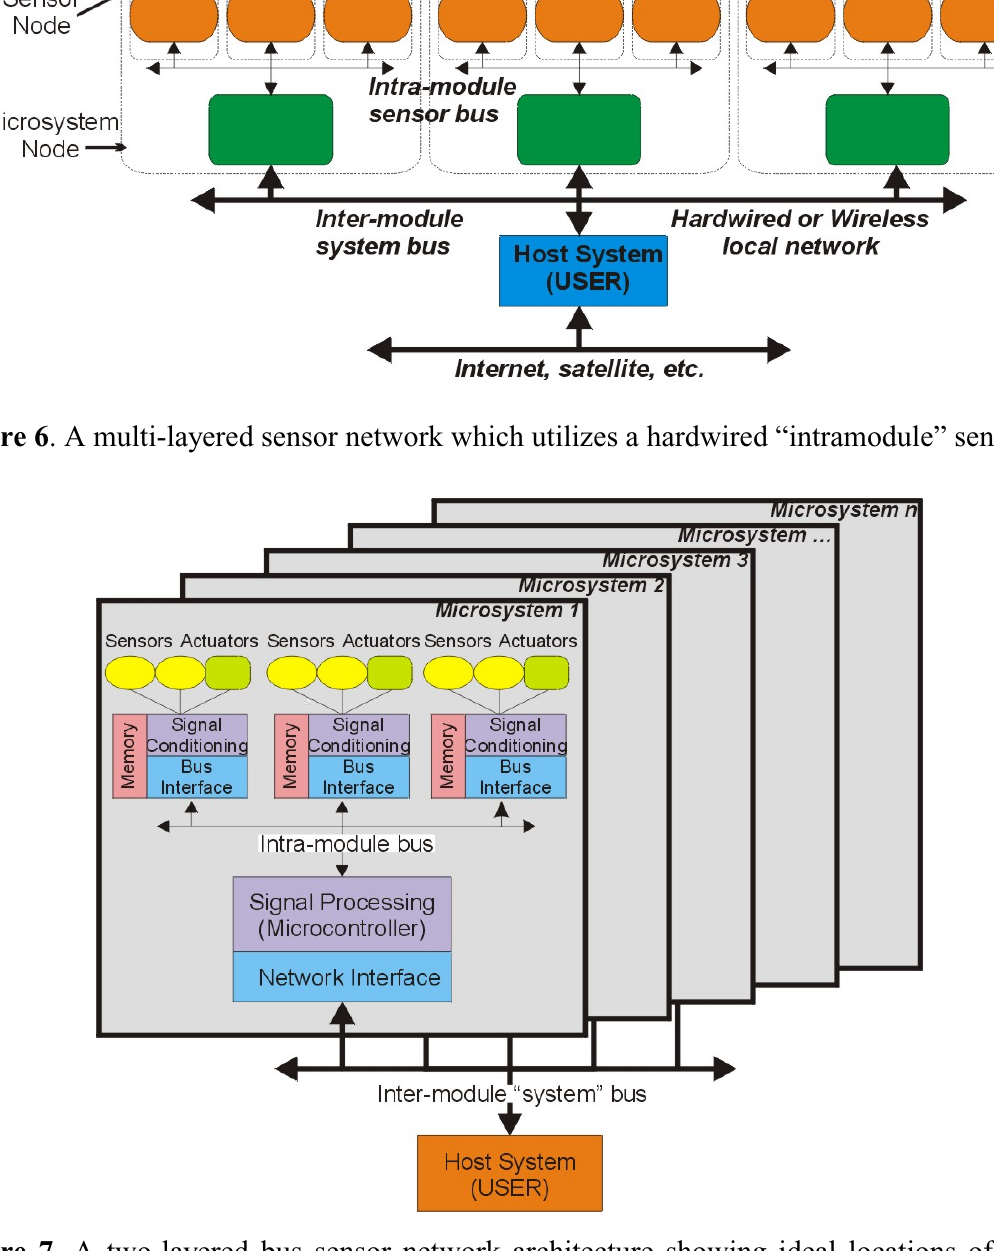
Figure 7. A two-layered bus sensor network architecture showing ideal locations of signal conditioning/processing and networking